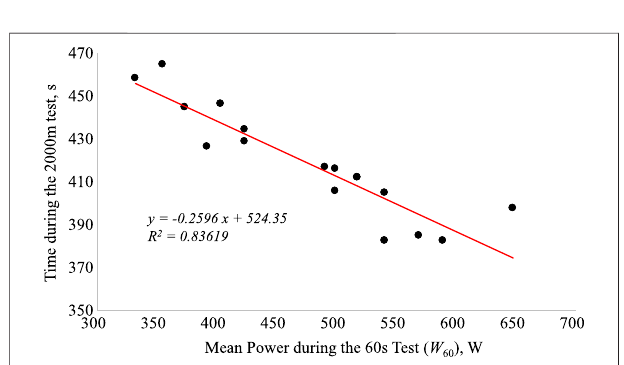
FIGURE 2 | The relationship between the 2000 m performance time ( t 2000 ) and mean power ( W 60 ) during the 60 s all-out test.